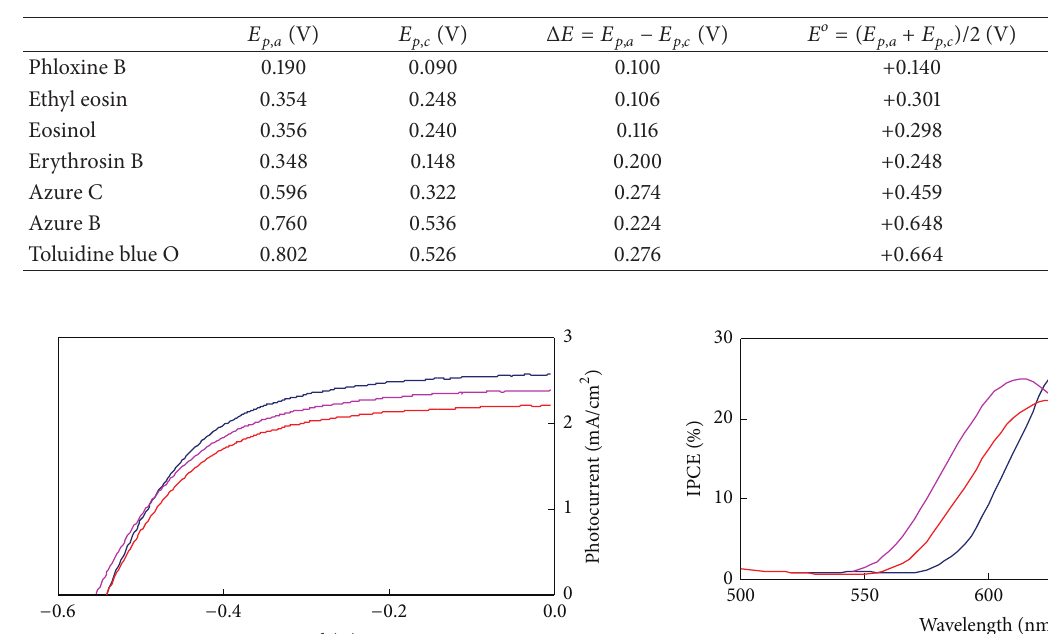
Table 6: Electrochemical parameters of fluorone and thiazine based dyes.